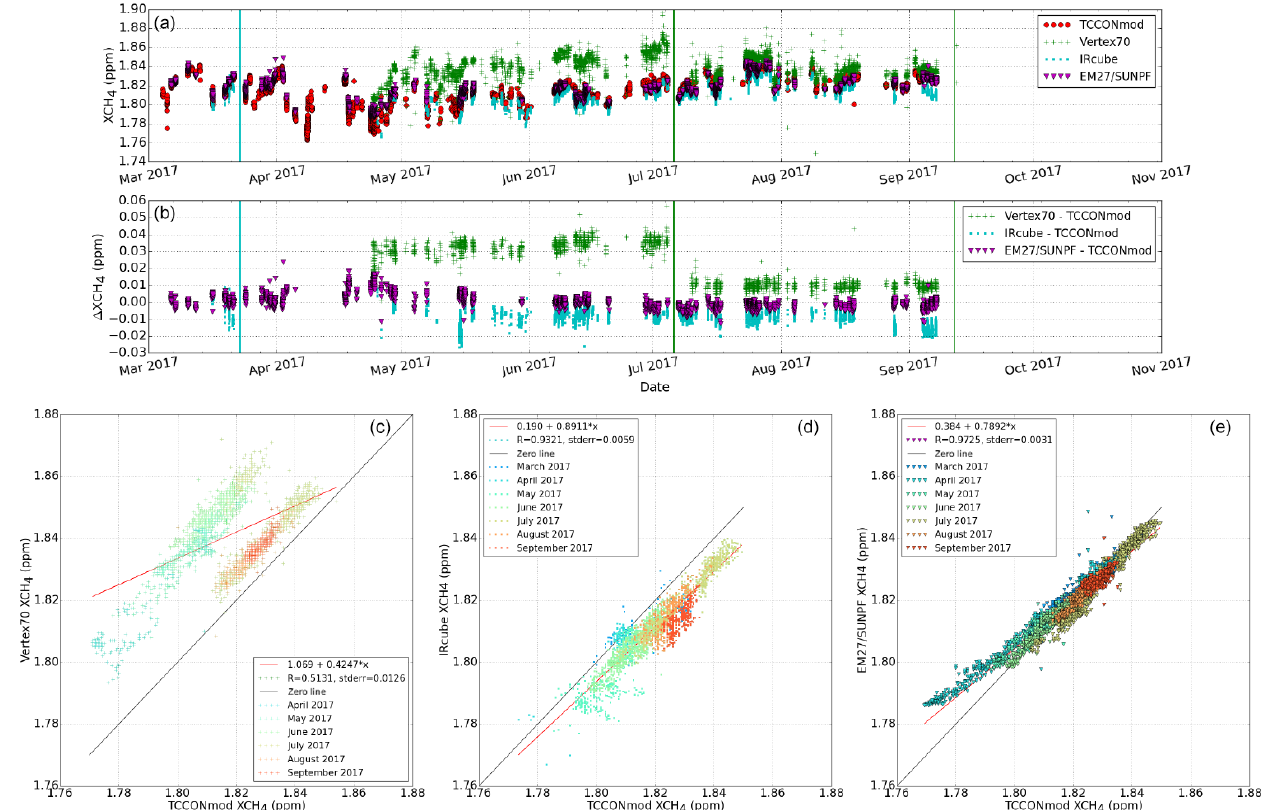
Figure 8. Time series of XCH 4 retrievals for TCCONmod, Vertex70, IRcube, and EM27/SUN using the standard procedure with the TCCON a priori for measurements performed at Sodankylä in 2017 (a) and the difference of XCH 4 time series for each instrument relative to the reference TCCONmod results (b) . The correlation plots of XCH 4 from Vertex70, IRcube, and EM27/SUN instruments vs. TCCONmod for all measurements with SZA < 75 ◦ : (c) Vertex70 vs. TCCONmod; (d) IRcube vs. TCCONmod; (e) EM27/SUN vs. TCCONmod. The colours represent the measurements performed during the different months of the